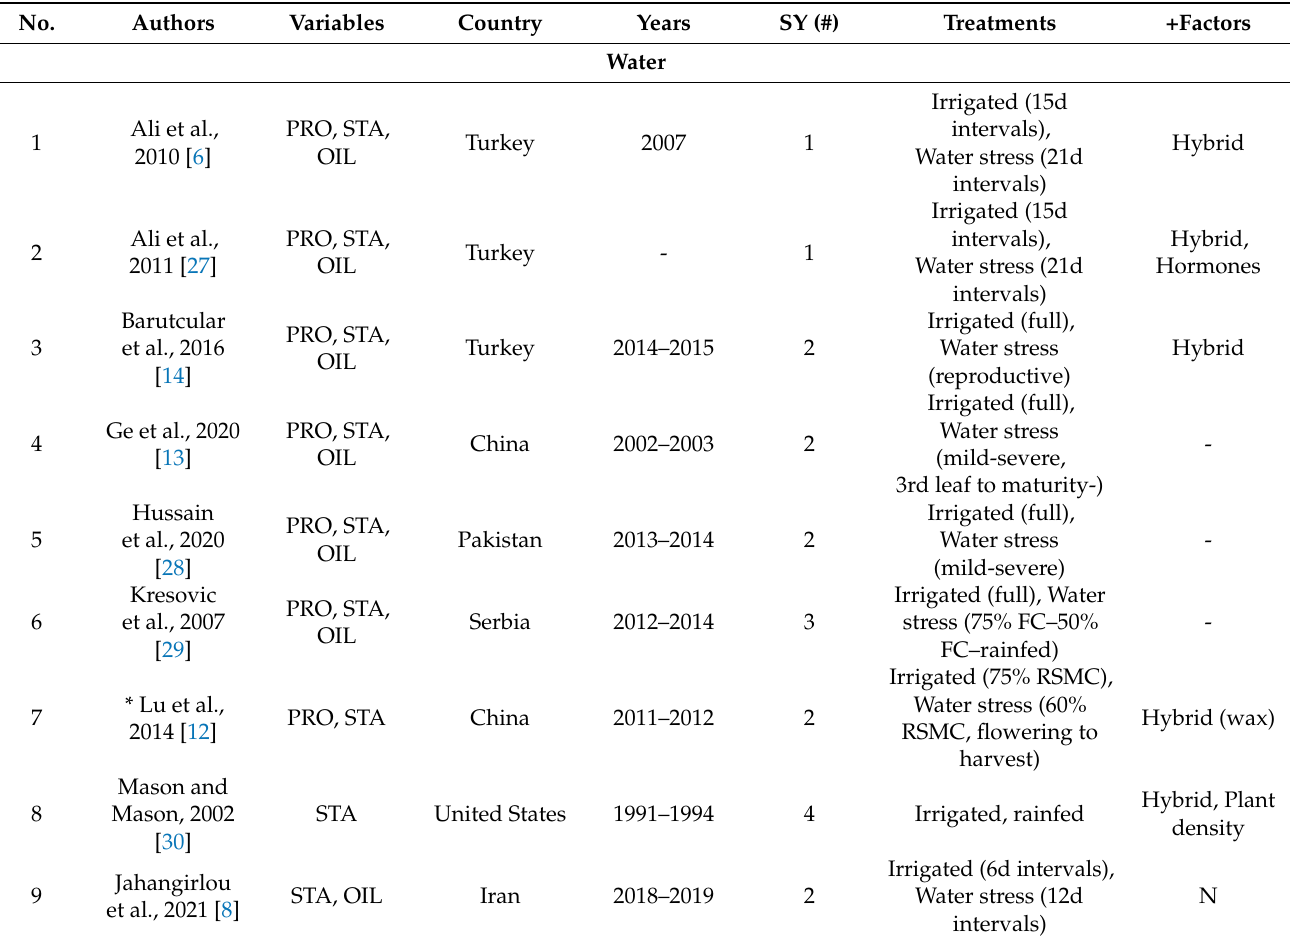
Table 1. Data sources, measured grain quality variables, country, number of site-years per study (SY), water or nitrogen treatments, and other factors evaluated. PRO = protein, STA = starch, OIL = oil, FC = field capacity, RSMC = relative soil moisture content. * Performed under controlled